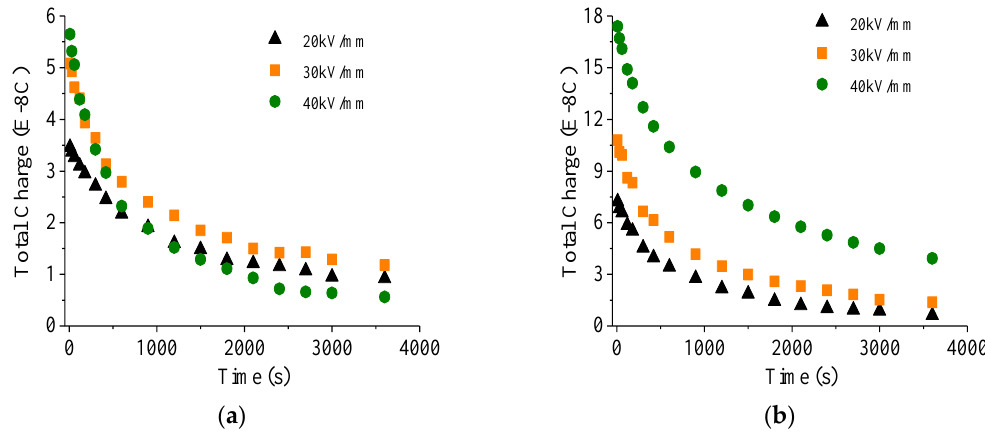
Figure 5. Charge detrapping process in oil impregnated insulation paper with new and aged oil after being applied DC electrical field 20 kV/mm, 30 kV/mm, and 40 kV/mm for 1 h. ( a ) sample with new oil; ( b ) sample with aged oil.